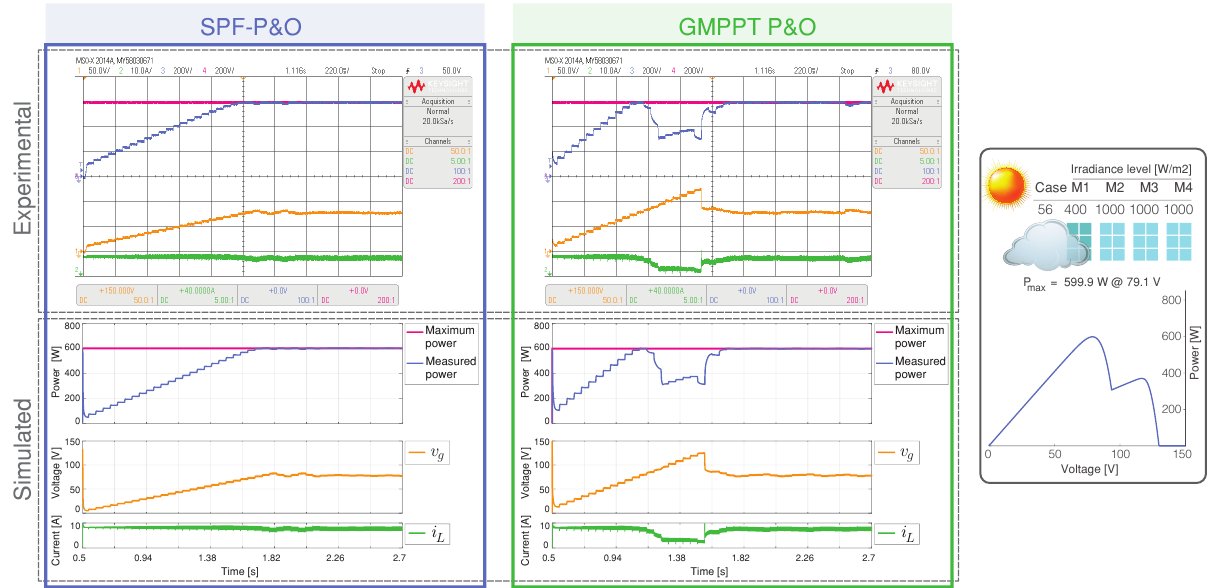
Figure 5. Simulated and experimental dynamic behavior of the MPPT algorithms for Scenario 1 and an output voltage V o = 160 V. The proposed MPPT algorithm ( left ) is compared with GMPPT P&O ( right ). CH1: v g (50 V/div), CH2: i L (10 A/div), CH3: Maximum power (200 W/div), CH4: Measured power (200 W/div) and a time base of 220